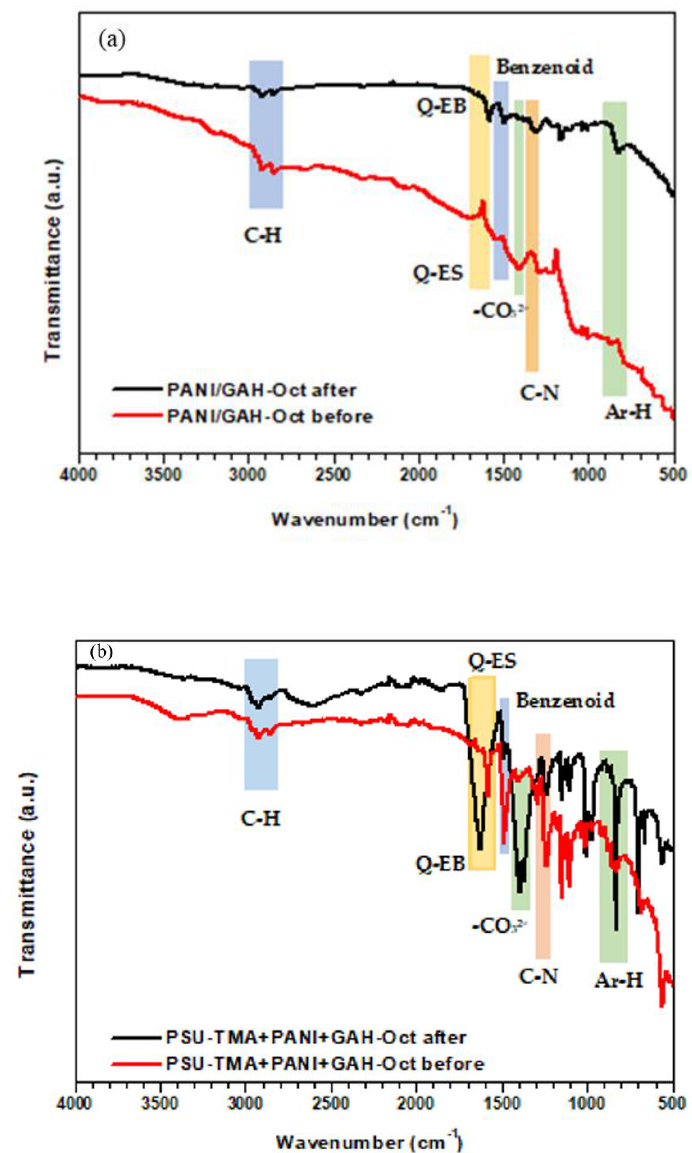
Figure 13. FTIR spectra of nanocomposite ORR electrodes before and after use (Q: quinoid, ES: emeraldine salt, EB: emeraldine base). ( a ) PANI + GAH-Oct; ( b ) PSU-TMA + PANI + GAH-Oct